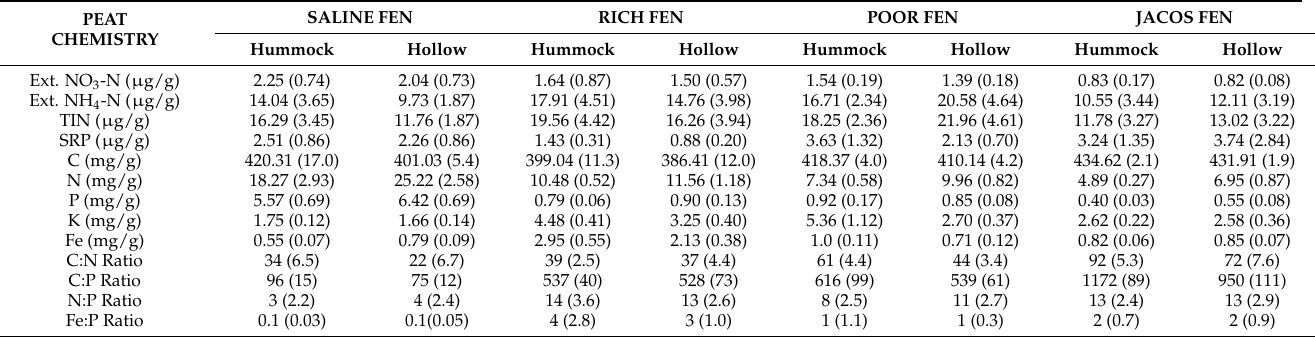
tion samples across the range of fen types and within site